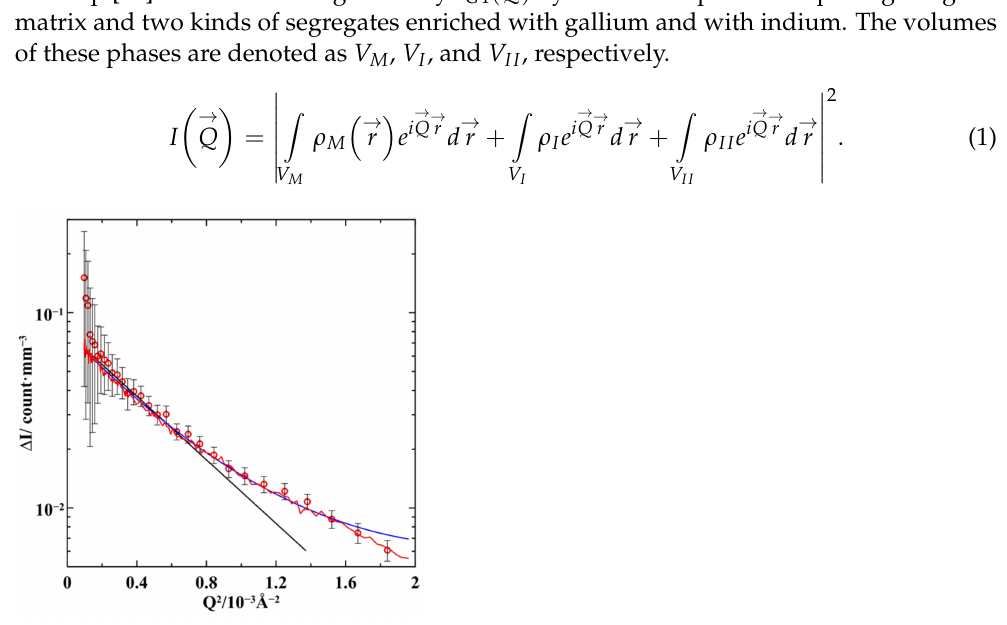
Figure 4. The dependence of the difference ∆ I of the scattering intensities by G6 and G4 on Q 2 . The black line is a standard Guinier approximation, the blue line corresponds to the extended Guinier model. The red line shows the Monte Carlo simulation.